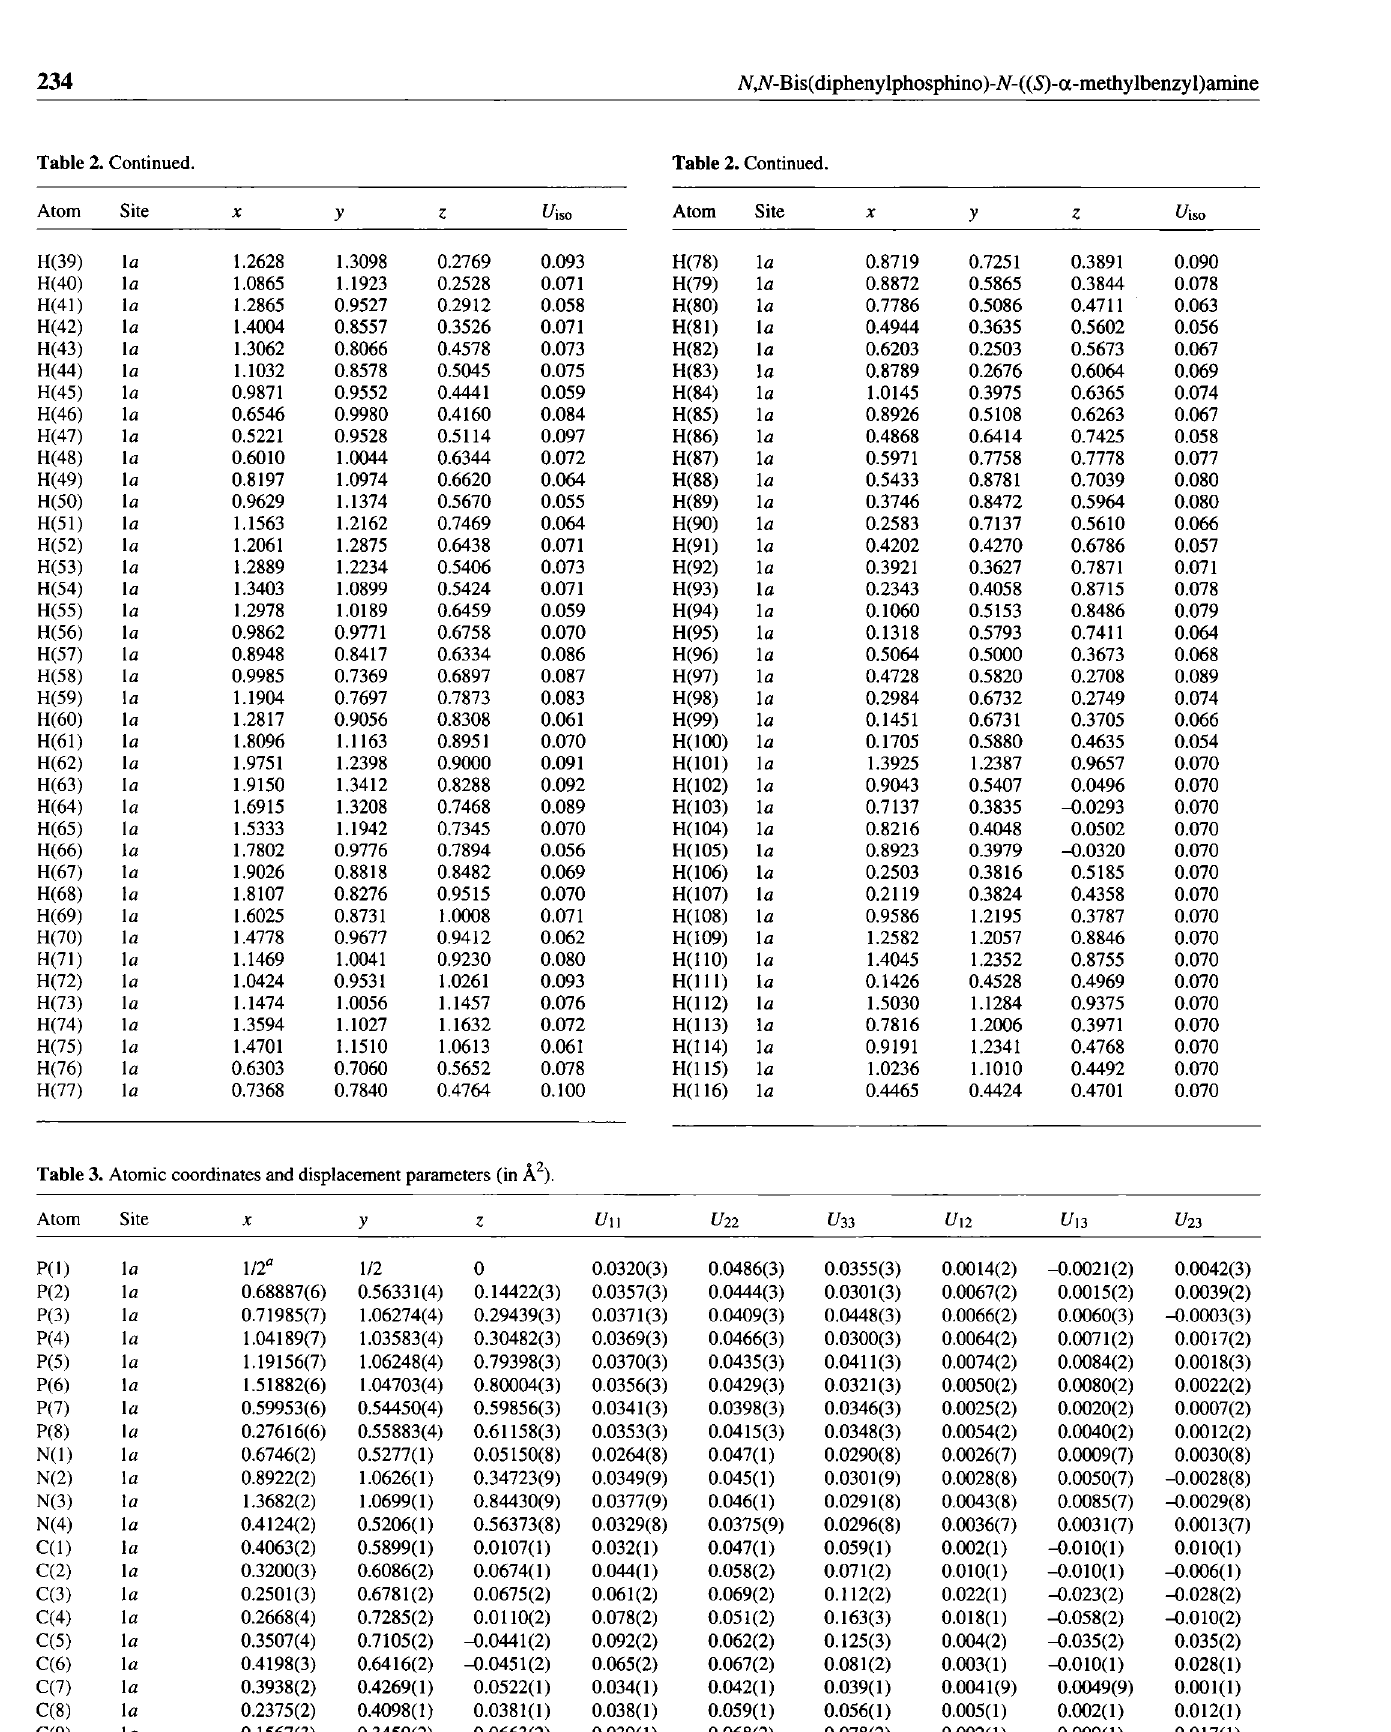
Table 3. Atomic coordinates and displacement parameters (in A 2